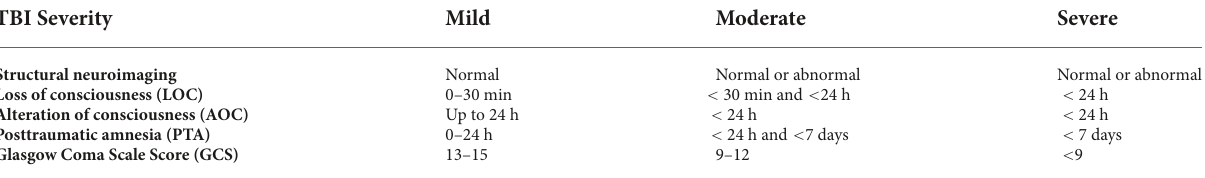
TABLE 1 Current classification system for traumatic brain injury described in the VA/DoD Clinical Practice Guideline for the management of Concussion-Mild Traumatic Brain